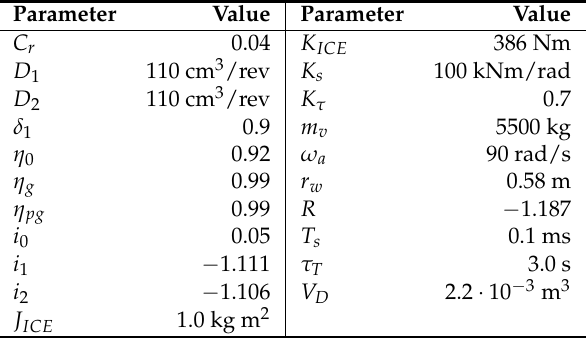
Table A1. Numerical values for the main simulation parameters used for HWIL simulation of the reference transmission. Negative gear ratios indicate external